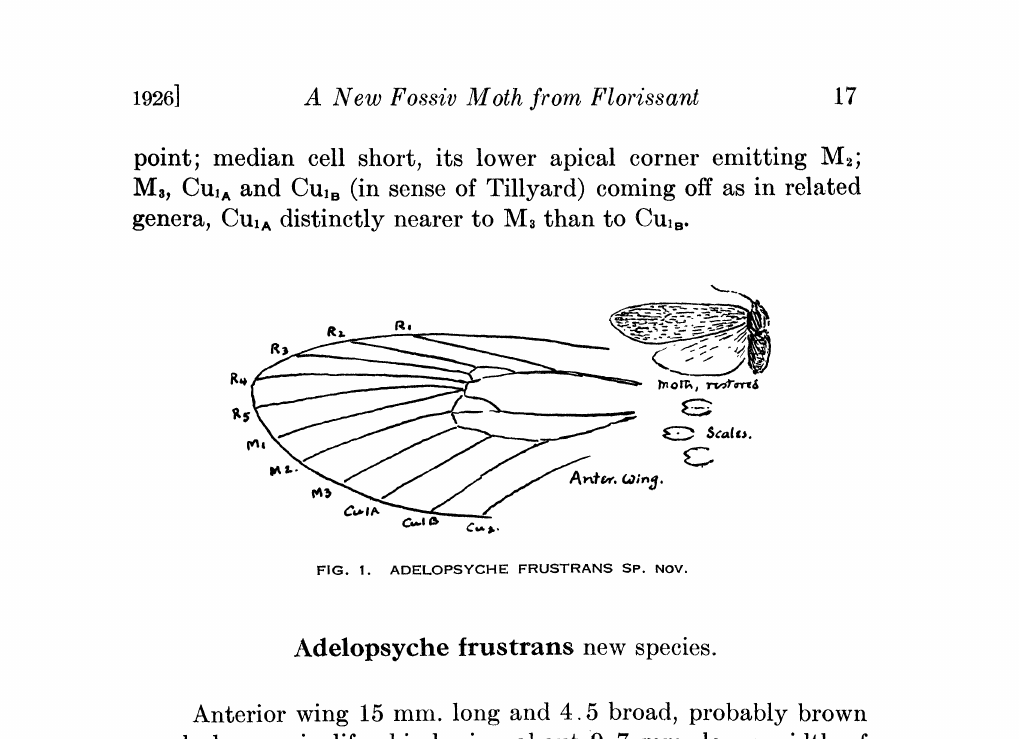
FIG. 1. ADELOPSYCHE FRUSTRANS SP.